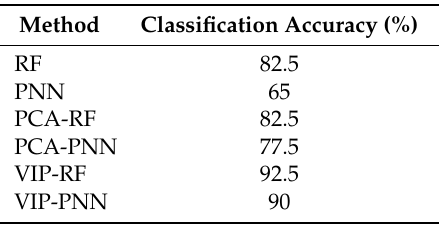
Table 4. Classification ability comparison.